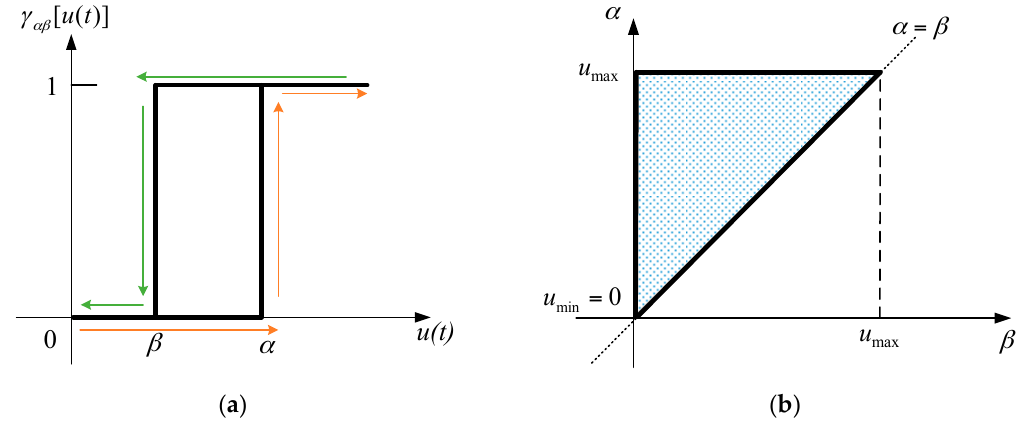
Figure 5. ( a ) Hysteresis operator; ( b ) The Preisach plane.